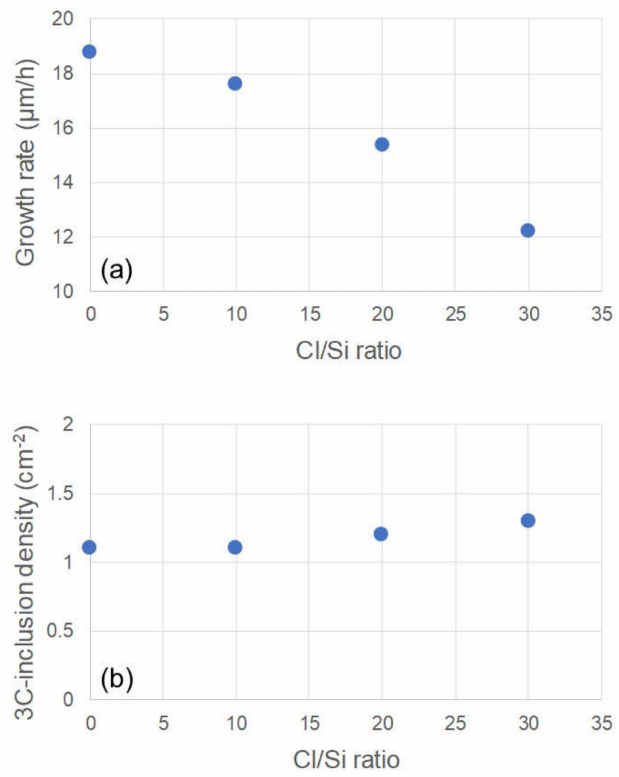
Figure 4. Dependence of ( a ) the growth rate and ( b ) the 3C-inclusion density of the on-axis 4H-SiC epitaxial layers on the Cl / Si